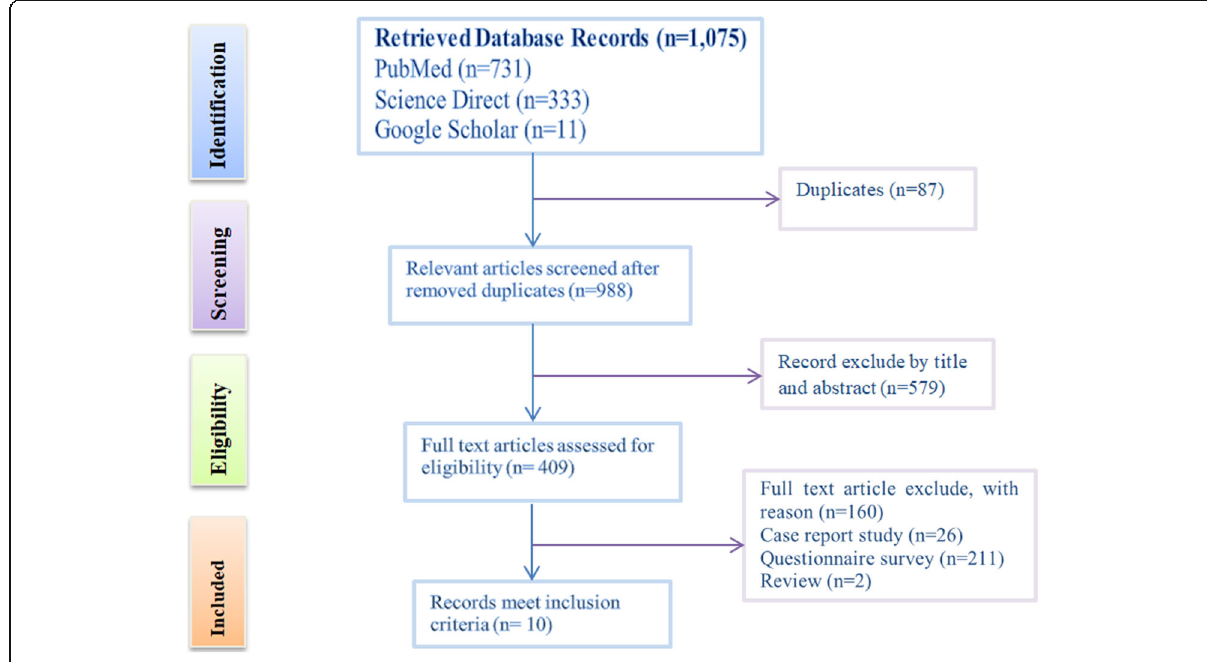
Fig. 1 Flow diagram of the selection of eligible studies